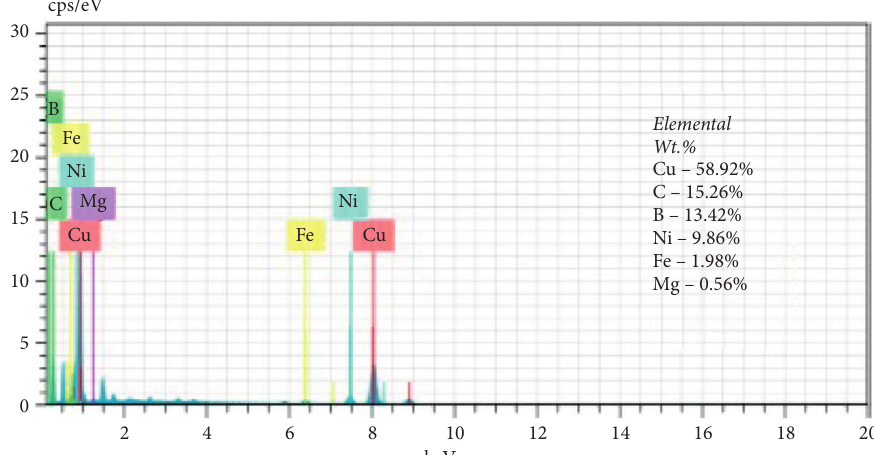
Figure 8: EDS (multipoint) analysis of FSP sample indicating reinforcement of B